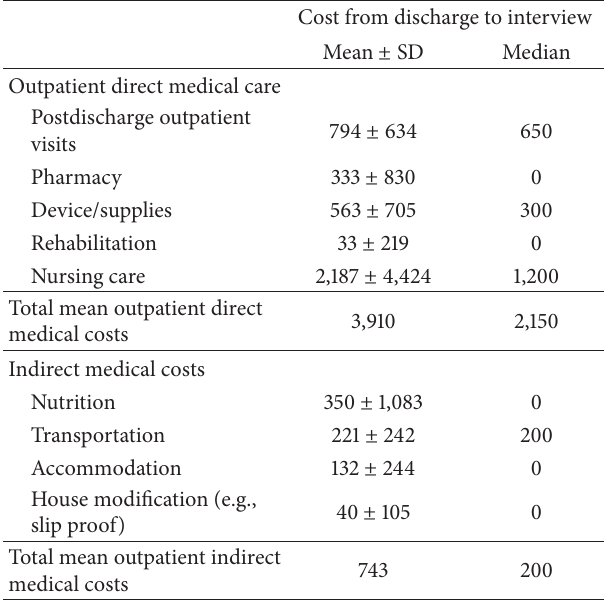
Table 3: Outpatient direct medical and indirect medical care costs ∗